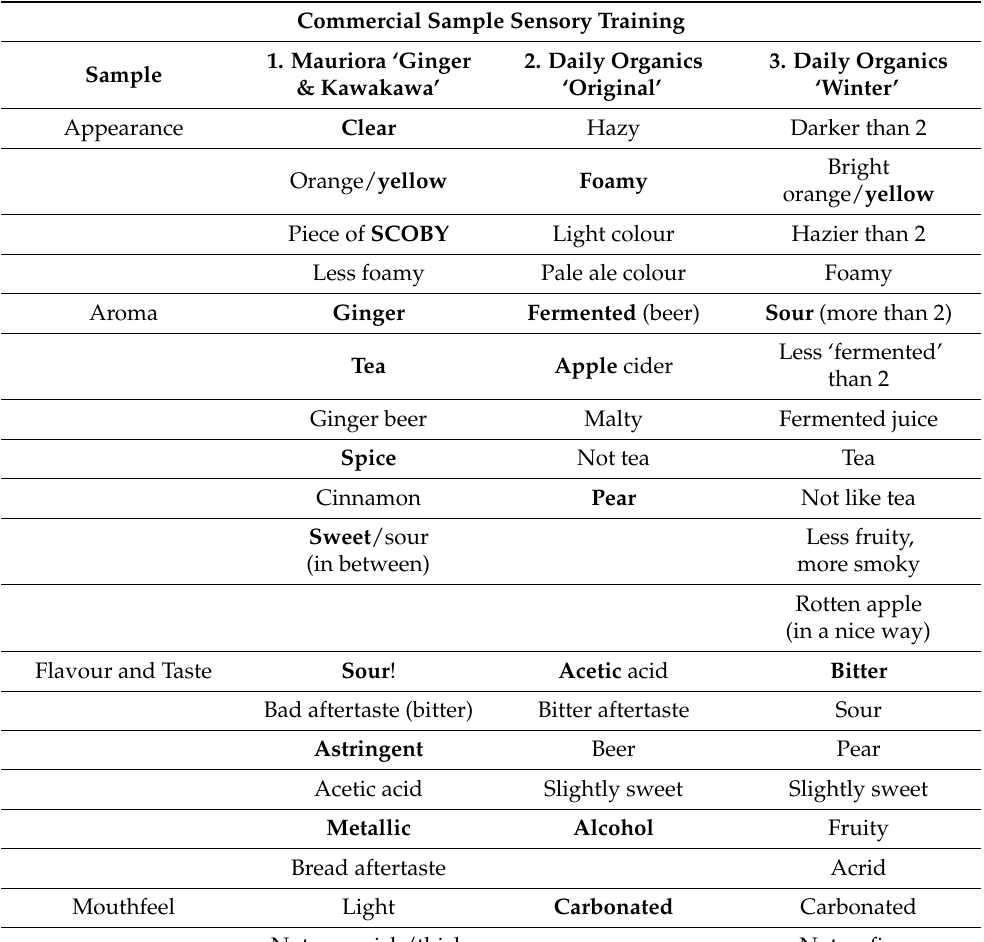
Table 2. The training table for the focus group using three commercially available Kombucha beverages. The words in bold refer to those used as base descriptors for the final Kombucha